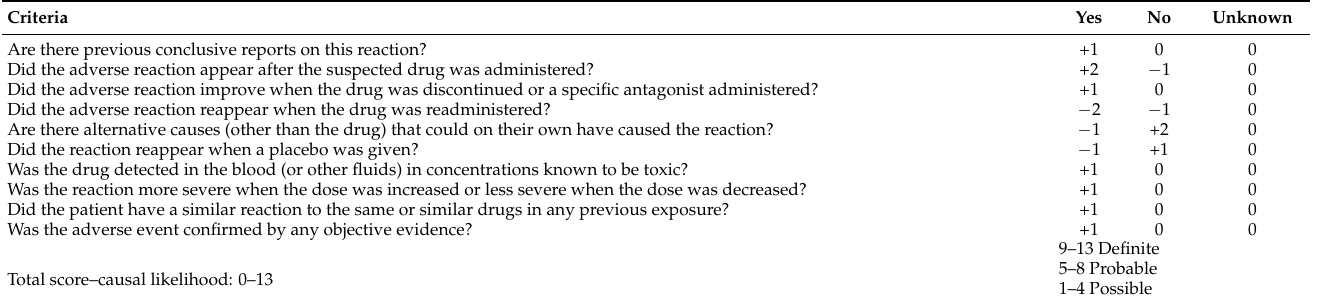
Table A2. The Naranjo Criteria for Quantitative Assessment of Causation between a Medication and an Adverse